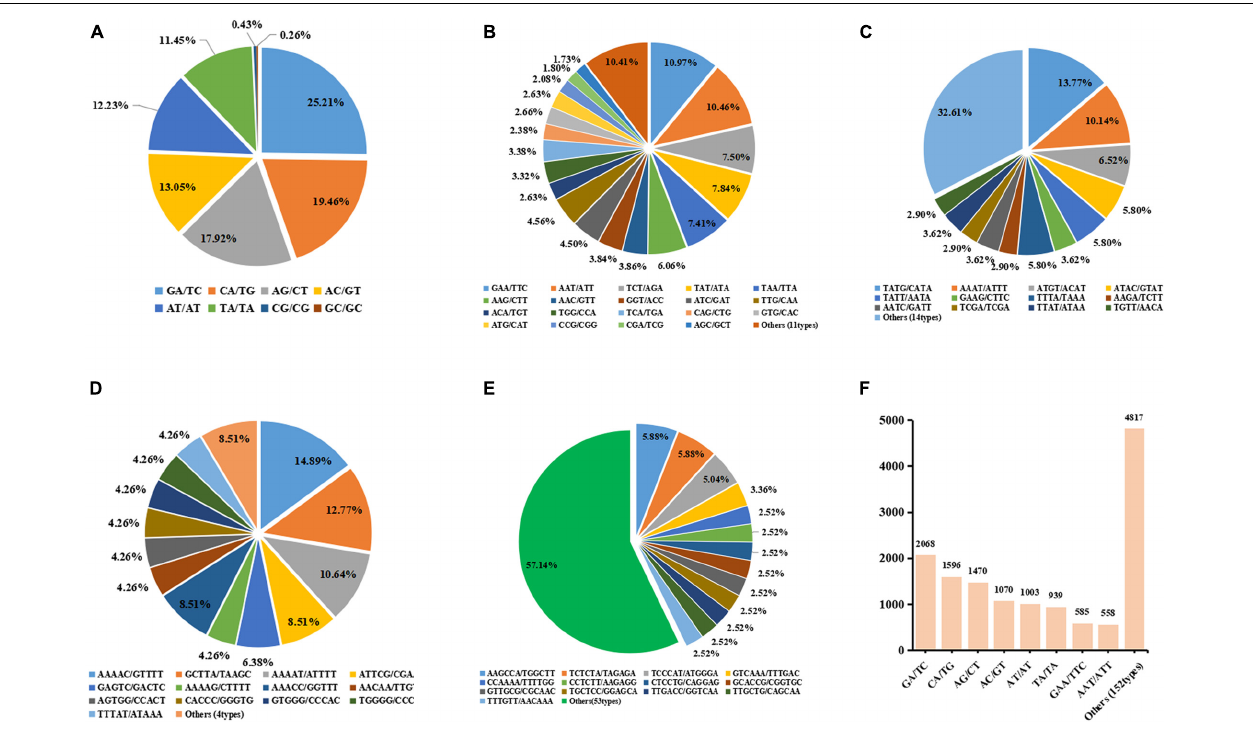
FIGURE 6 | Proportion of different repeat motif types in Dinucleotides (A) , Trinucleotides (B) , Tetranucleotide (C) , Pentanucleotide (D) , and Hexanucleotide (E) . Plot (F) shows the most copious motif types with number of > 500.